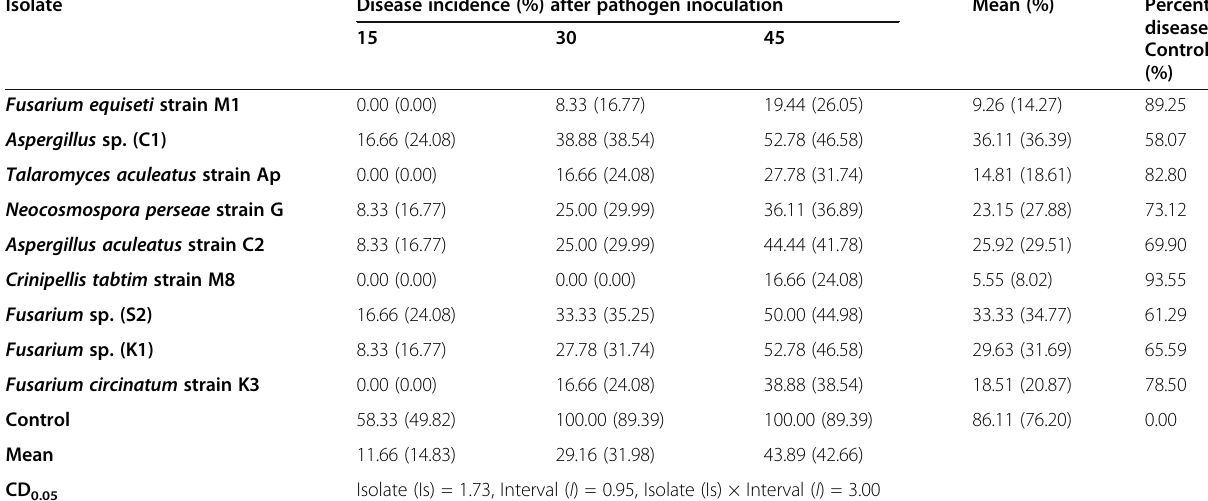
Table 3 Effect of seed dip treatment with fungal root endophytes on white root rot of apple in glasshouse conditions Isolate